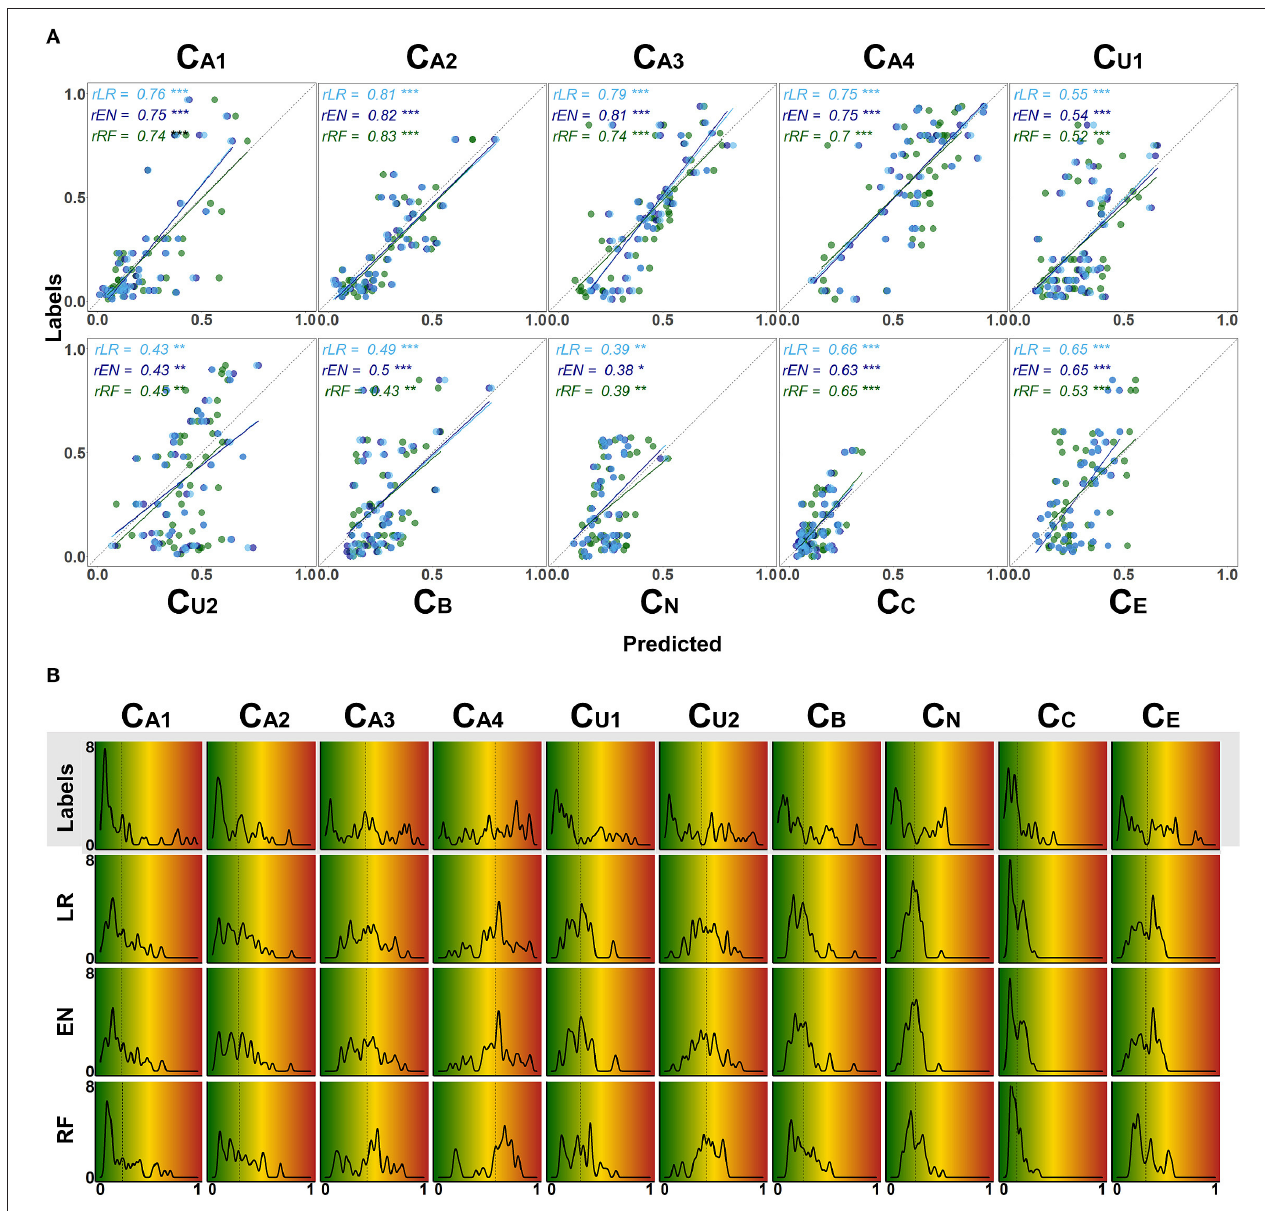
FIGURE 7 | Detailed overview on model performance for different CAFPAs. LR (lasso regression); EN (elastic net); RF (random forests) (A) Predicted vs. labeled CAFPA values (for the test set, averaged over imputed data sets) for all CAFPAs. The three models are color-coded. The Pearson correlation r and corresponding linear associations are depicted in the corresponding color. The level of significance p is indicated by *, **, ***, for p < 0.05, p < 0.01, p < 0.001, respectively. The dotted line indicates perfect prediction. (B) Absolute frequency density plots (bandwidth = 0.015) for the, ten CAFPAs. Different rows depict the distributions of the labeled CAFPAs, next to the distributions achieved by the three models. The x -axis indicates the CAFPA values; the y -axis the absolute frequency of the labeled CAFPAs and those predicted by the respective model. In the background, the color codes corresponding to the CAFPA interval [0 1] are depicted (cf. Figures 1B , 9 ).